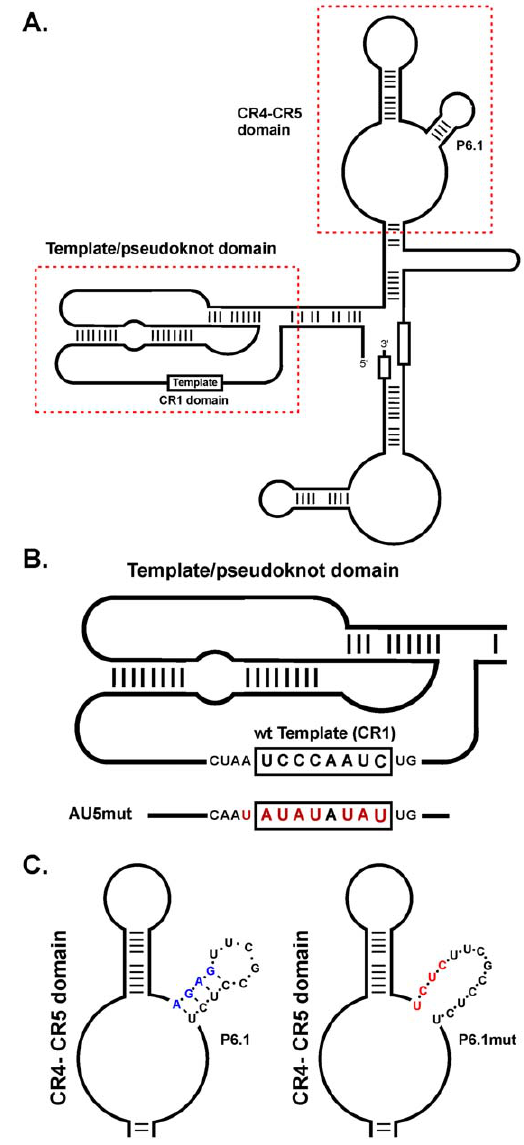
Figure 1. Schematic diagram of MDV vTR secondary structure, location of the CR1 and CR4-5 domains, and incorporated mutations. A) The pseudoknot (core), containing the template sequence, and the CR4-CR5 domains containing the P6.1 stem loop, are indicated with boxes. B) The pseudoknot domain including the sequence of wild-type vTR template and AU5 template mutant (AU5). Nucleotide changes in the template sequence are shown in red. C) The CR4-CR5 domain showing detailed representations of the P6.1 stem-loop and the structures of wild-type P6.1 (left) and mutant P6.1 stem-loop (P6.1mut) (right) areshown. Nucleotide changes of the wt P6.1 stem-loop (blue) are shown in red and have been previously published [22].